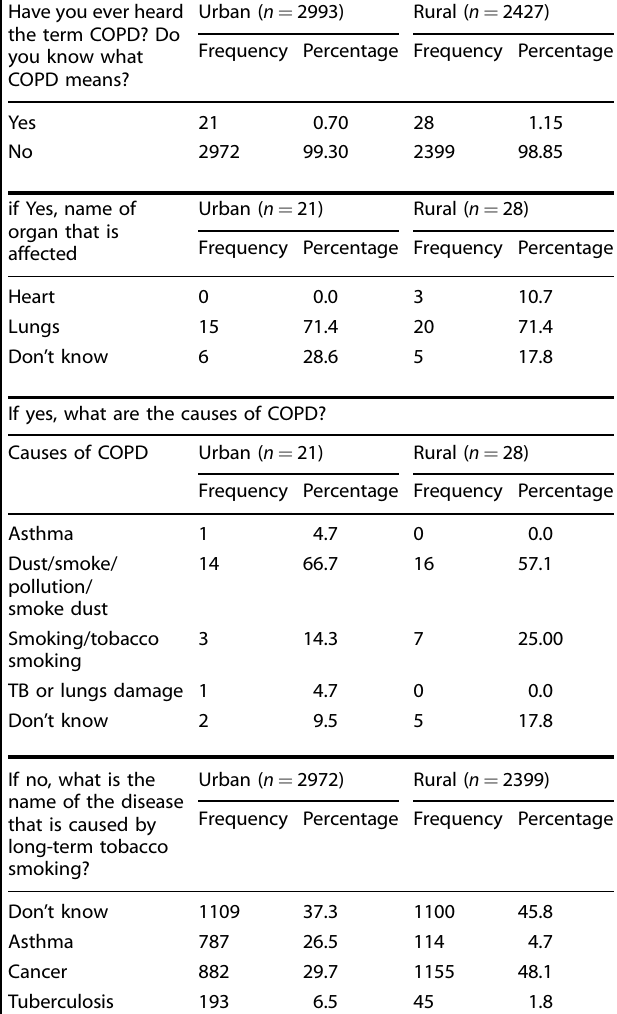
Table 2. Results of the responses for the four questions on COPD awareness that were asked to the study